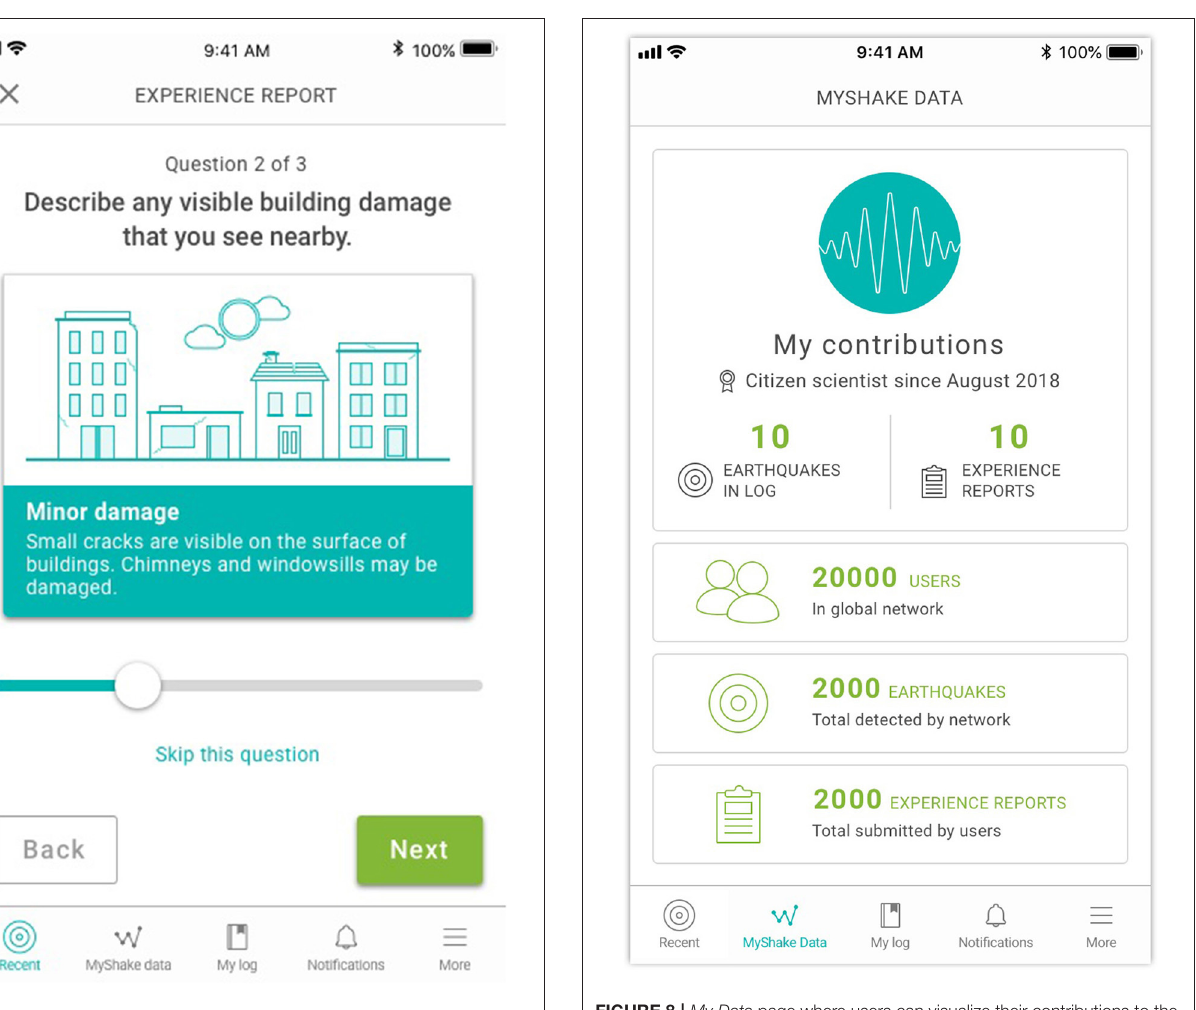
FIGURE 7 | Experience Report page where user can input any visible damage they see nearby.